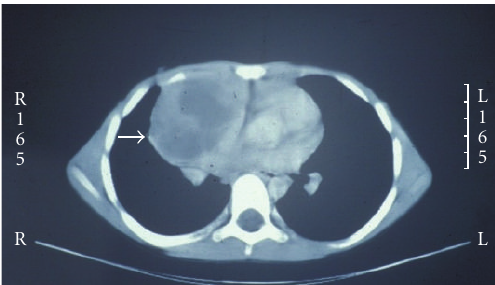
Figure 1: CT scan demonstrating a large cystic anterior mediastinal mass